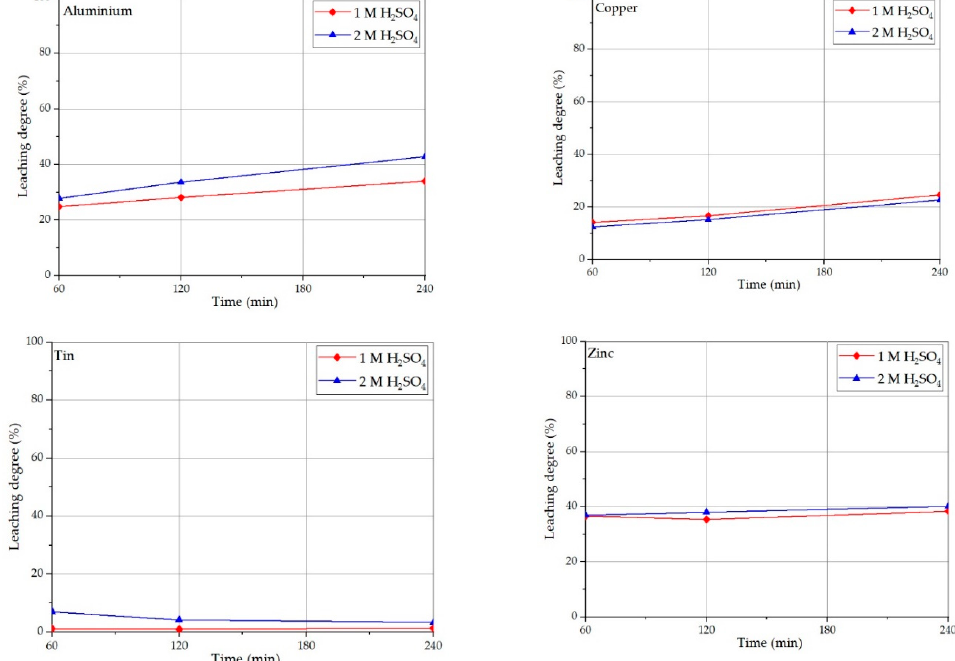
Figure 5. Influence of sulfuric acid concentration on leaching for a S/L ratio of 0.058 (70 g of PPCB).